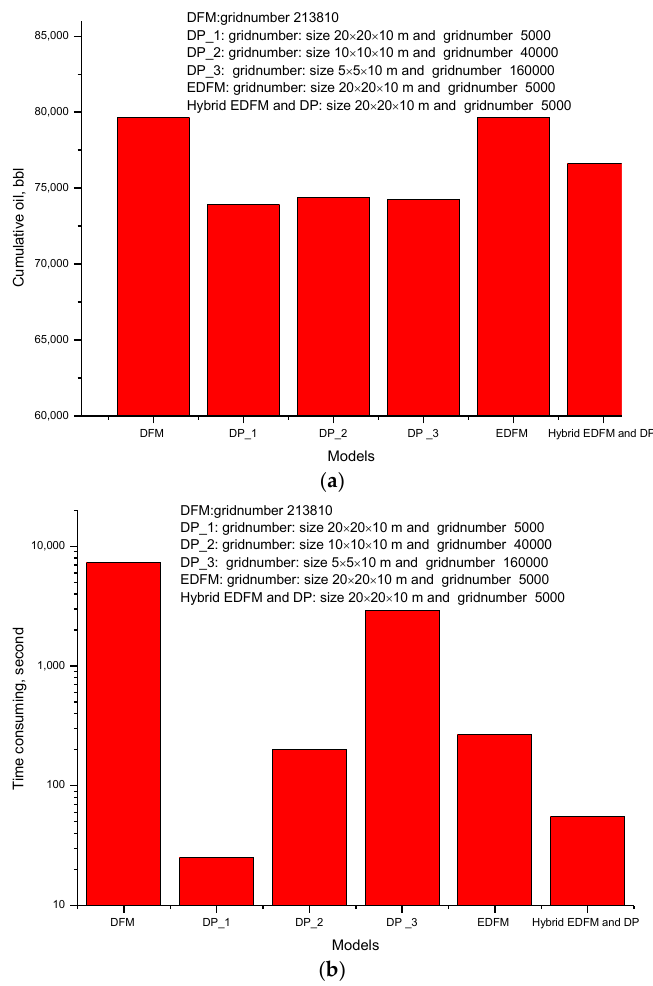
Figure 8. Simulation results for different models. ( a ) Cumulative oil for different models; ( b ) Time consumption for different models.